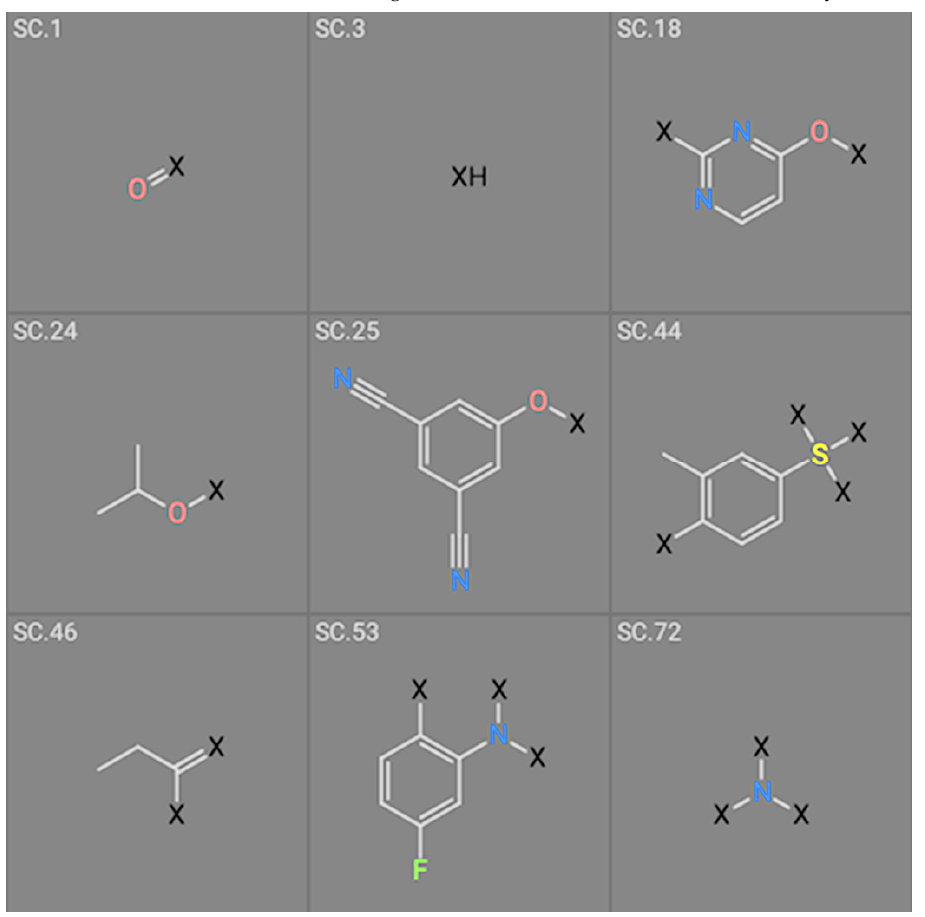
Table 3. Substructures used in fragment-based QSAR for wt and mutated enzyme